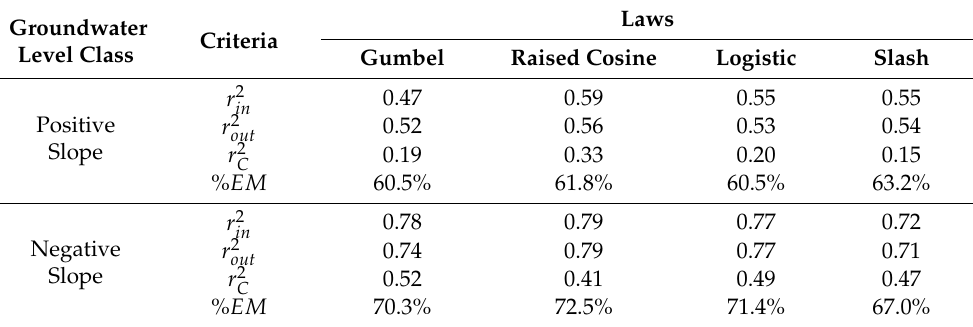
Table 10. Pearson’s coefficients of correlation ( r 2 ) between the measured water level distribution and the composite pdf; correlations between the model correctness and the empirical C PICP calculated for each class of 20-cm groundwater levels ( 𝑟 (cid:3004)(cid:2870) ); and Error Margins (EM).